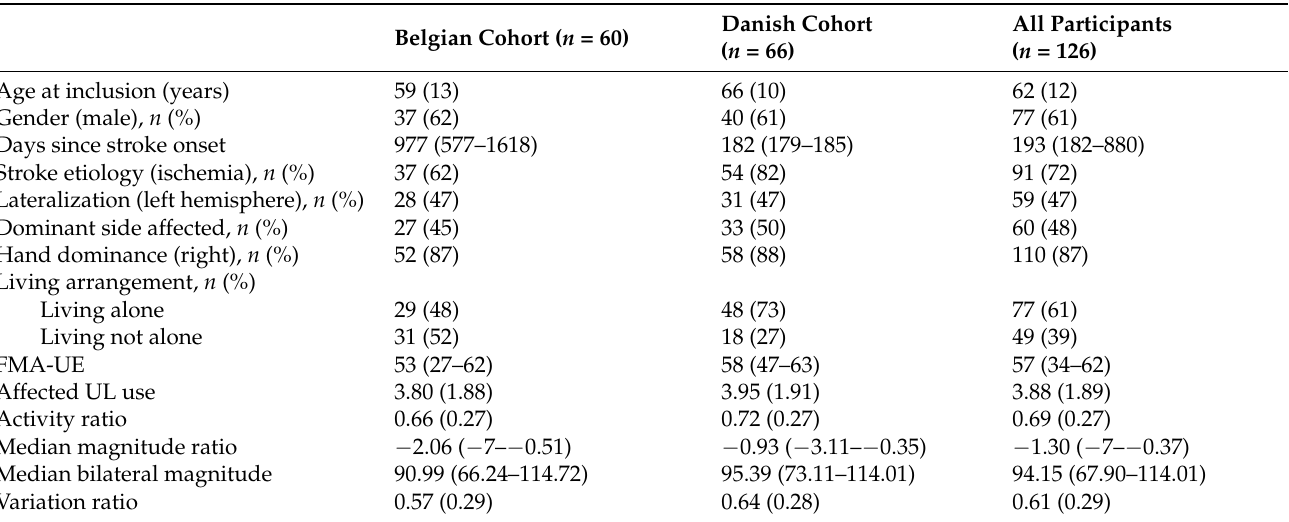
Table 2. Demographic and stroke-related characteristics presented as medium (SD), median (Q1–Q3), or number